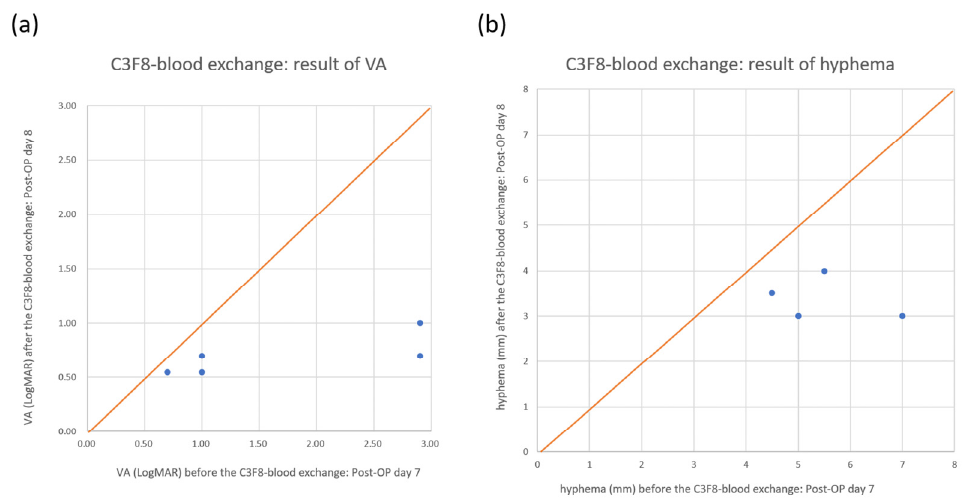
Figure 4. Visual acuity (VA) and hyphema changes after the air–blood exchange procedure with 12% perfluoropropane. From the scatter plot, we can see that all the spots are below the 45° orange line. This means that VA ( a ) and hyphema ( b ) were improved in all the patients.